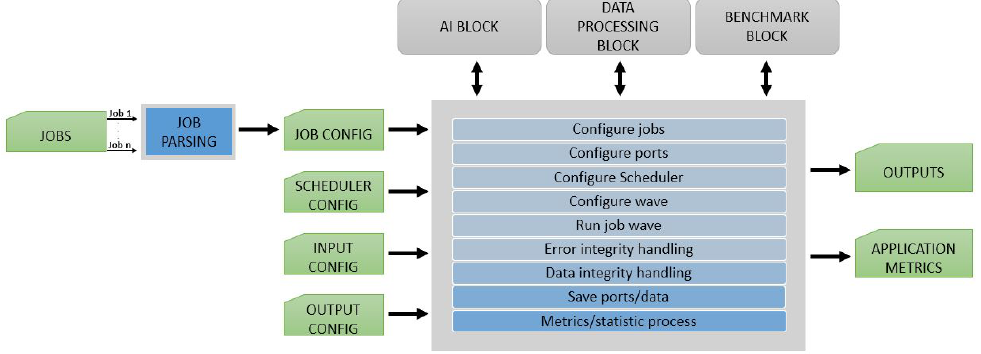
Figure 7. EECVF application block